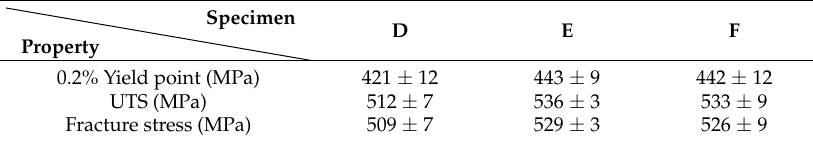
Table 6. Mean mechanical property values for customised specimen sets.